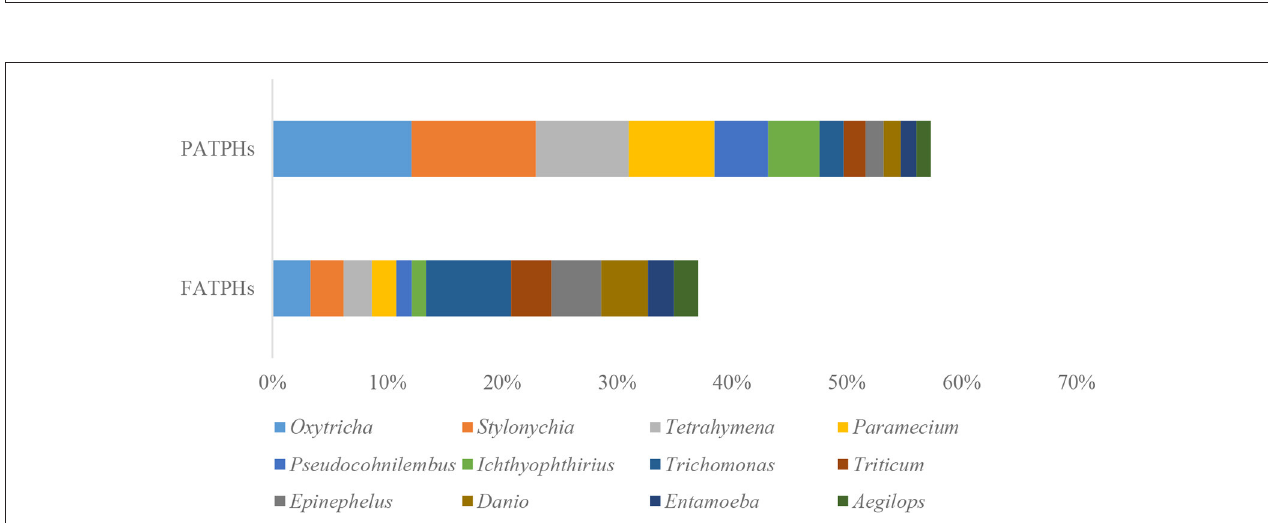
Frontiers in Veterinary Science |